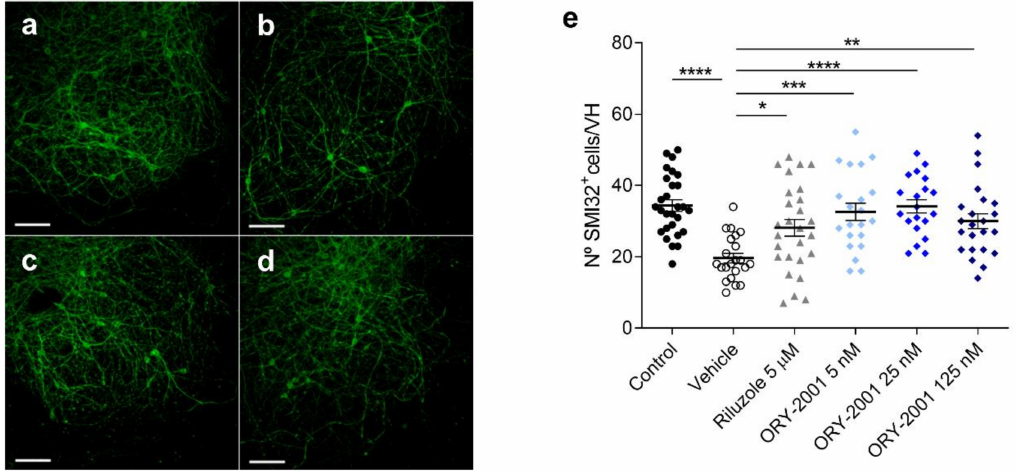
Figure 5. The effect of ORY-2001 on motoneurons injured by chronic excitotoxicity. ( a – d ) SMI-32 immunohistochemistry of ( a ) control spinal cord explants and spinal cord explants exposed to THA treated with ( b ) vehicle, ( c ) 5 µ M riluzole or ( d ) 5 nM ORY-2001 in a chronic excitotoxicity assay. Scale bar: 100 µ m. ( e ) Quantification of SMI-32+ motoneurons in control spinal cord explants ( n = 28) and explants exposed to THA treated with vehicle ( n = 22 hemislices), 5 µ M riluzole ( n = 27 hemislices) or with ORY-2001 5 ( n = 21 hemislices), 25 ( n = 20 hemislices) or 125 nM ( n = 23 hemislices). Data are pooled from 3 experiments performed on different days and presented as mean ± SEM. * p < 0.05, ** p < 0.01, *** p < 0.001, **** p <